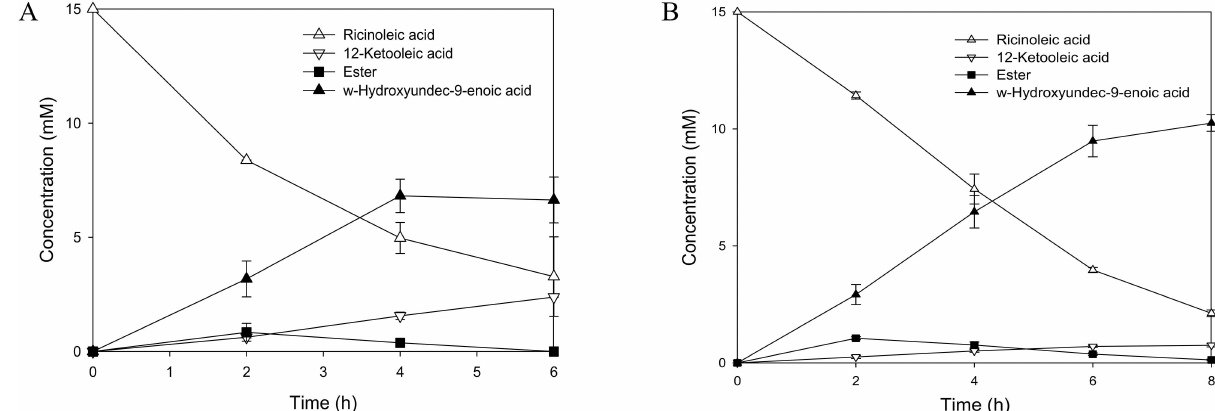
Fig 6. Time course of the biotransformation of ricinoleic acid. Ricinoleic acid ( triangle ) was convertedinto n-heptanoic acid ( 5 ) and 11-hydroxyundec-9-enoic acid ( 4 ) ( solid triangle ) (S1 Scheme) by the recombinant E . coli BL21(DE3) pACYC-ADH, pET-BVMO, pCOLA (A) and E . coli BL21(DE3) pACYC-ADH, pET-BVMO, pCOLA-RcsB-DsrA (B). The 12-ketooleicacid ( triangle down ) and ester ( solid square ) are intermediates. The biotransformation was initiated by adding15 mM of ricinoleicacid, 0.5 g L − 1 Tween 80, and esterase of P . fluorescens SIK WI into the culture broth of the strains at the early stationary growth phase (pH 8.0). The cell density was 3.2 g dry cells L − 1 . Values are the mean of more than three independent samples. Bars represent standard error of the mean.